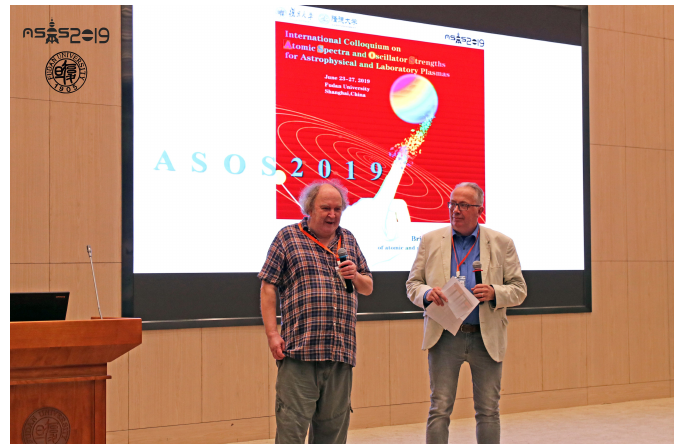
Figure 2. Prof. Roger Hutton ( left ) and Prof. Tomas Brage continue the opening speech and welcome to the participants.